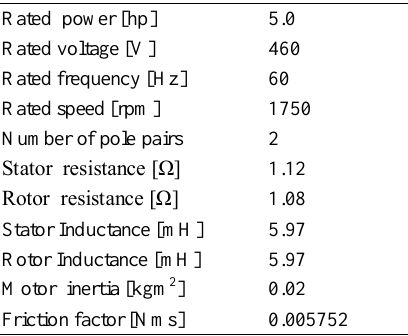
Table IV. Motor Nominal